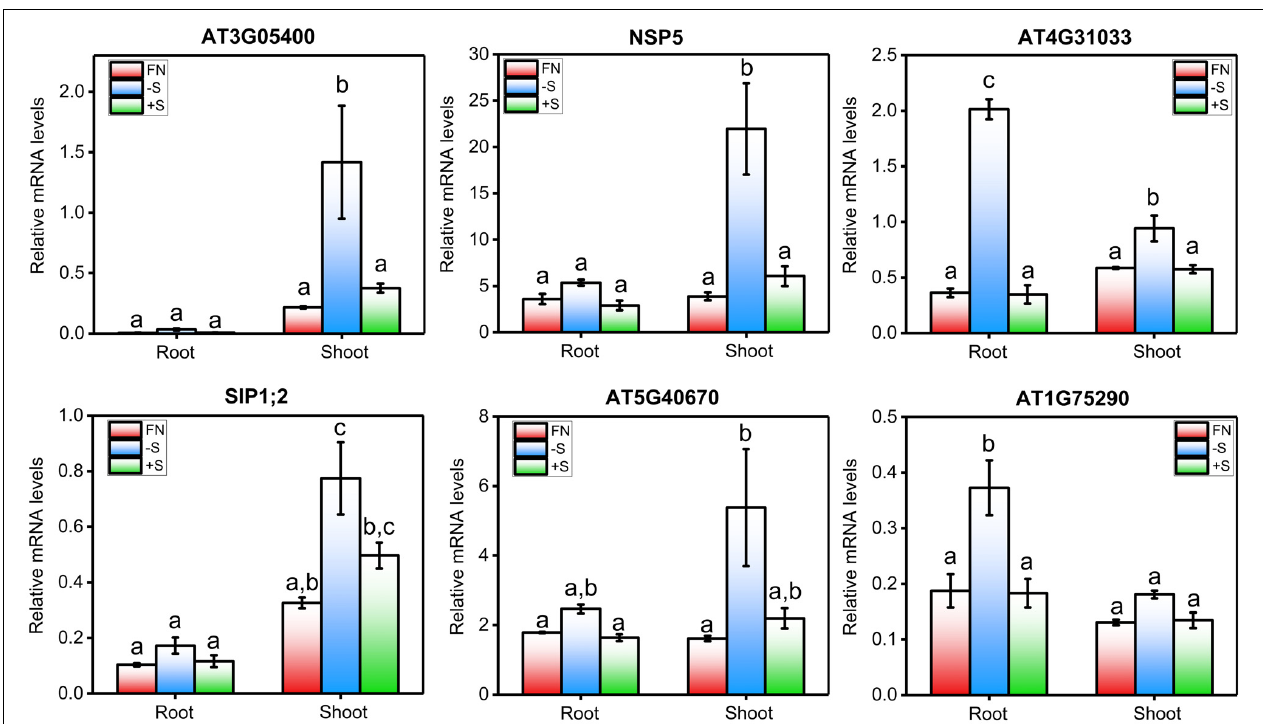
FIGURE 2 | qPCR-analyzed expression profiles of highly consistent genes whose function in the sulfate response is unknown. mRNA levels of six genes ( AT3G05400 , NSP5 , AT4G31033 , SIP1;2, AT5G40670, and AT1G75290 ) selected from the meta-analysis of the sulfate transcriptome data were analyzed by qPCR using the clathrin adapter gene (AT4G24550) as a normalization reference gene. Briefly, 5-day-old seedlings were transferred to liquid MS medium that was supplemented with sulfate (FN, 1.5 mM S) or not, after which the seedlings were allowed to grow for 2 days. At dawn on the 7 th day, the plants were treated with potassium sulfate (+S, 1.5 mM) or potassium chloride (–S, 3 mM). The mRNA levels were measured 2 h after treatment using the total RNA extracted from root and shoot samples. The values plotted correspond to the means of three independent experiments ± standard errors of the mean; 80 to 100 seedlings were used per replicate. The means with different lowercase letters are significantly different, p < 0.05 (one-way ANOVA and Tukey’s test).